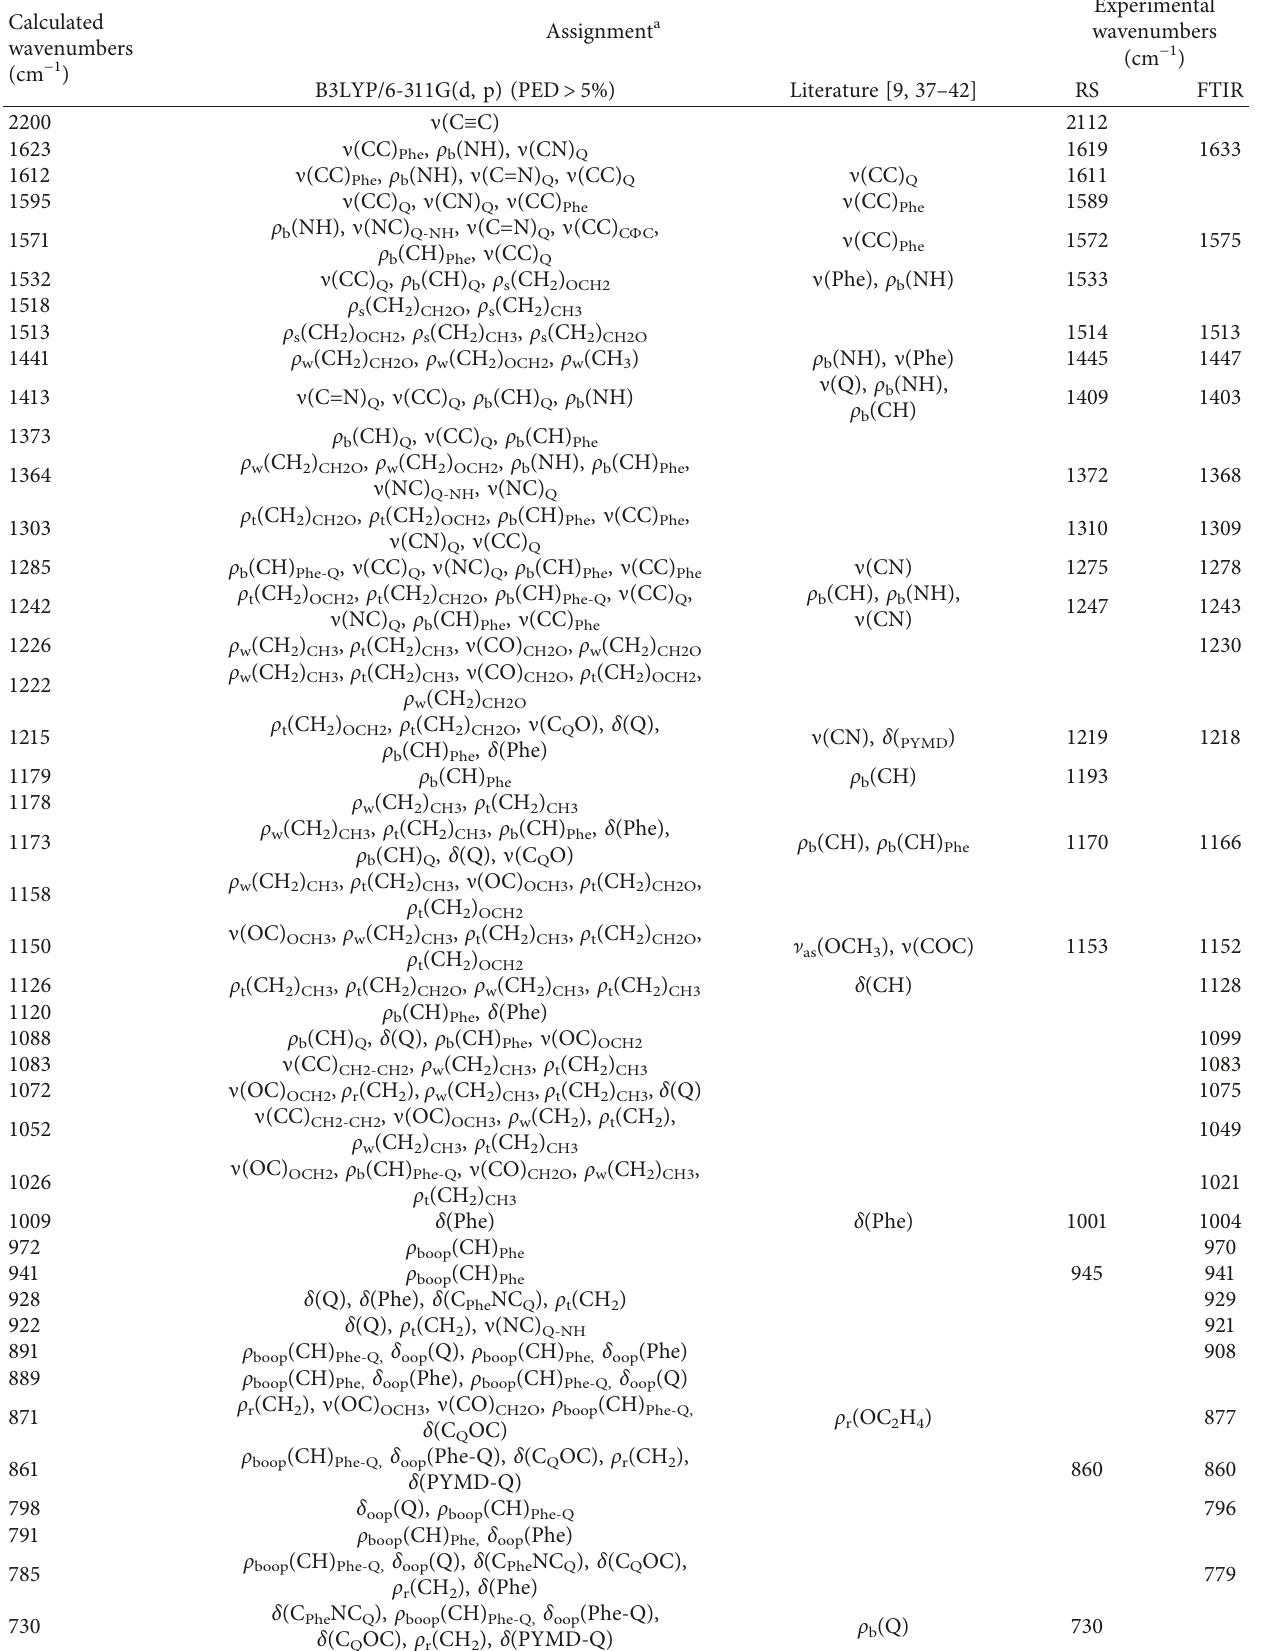
Table 2: Calculated (vacuum) and experimental wavenumbers for the RS and FTIR spectra of erlotinib in the solid state. Calculated